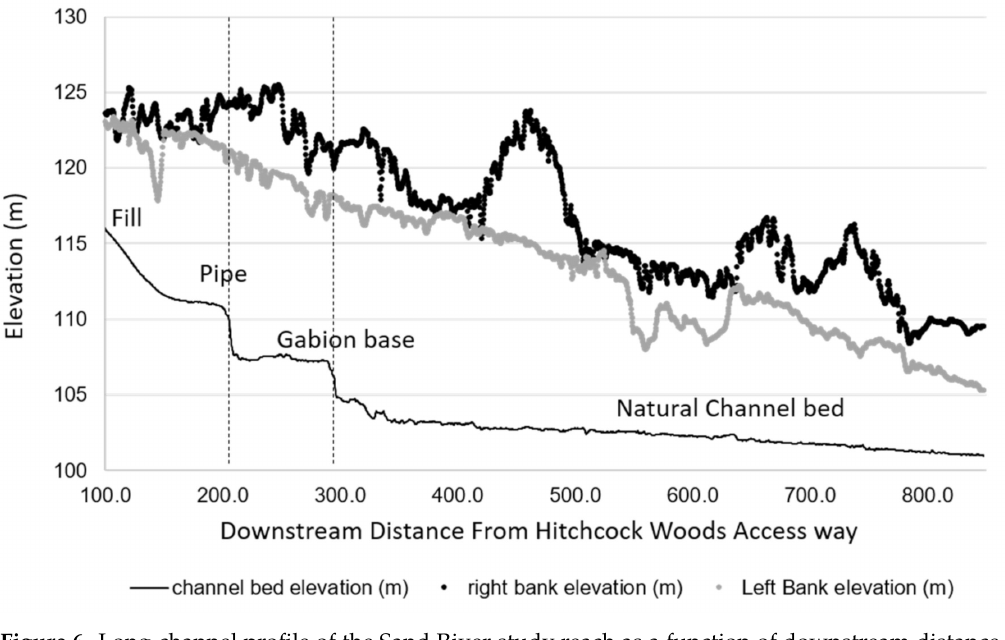
Figure 6. Long-channel profile of the Sand River study reach as a function of downstream distance from the Hitchcock Woods access way. The solid black line marks the location of the channel bed, while the black and gray dots mark the valley banks. A break in the channel bed slope occurs at 200 m downstream and is associated with opening of the outfall pipe. Another slope break occurs at 300 m downstream where the gabion canal transitions to natural channel